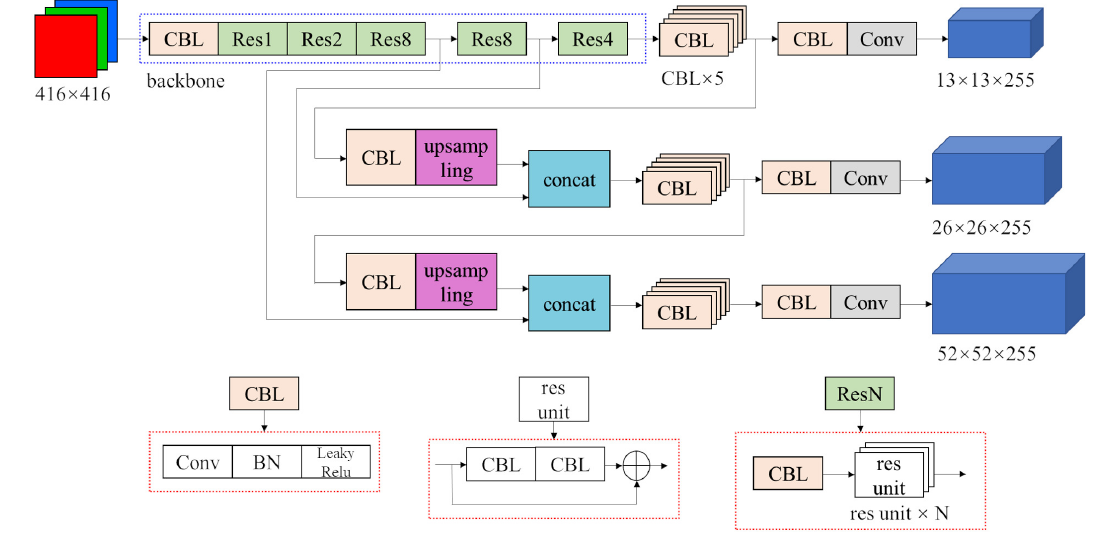
Figure 1. Structure of original YOLOv3